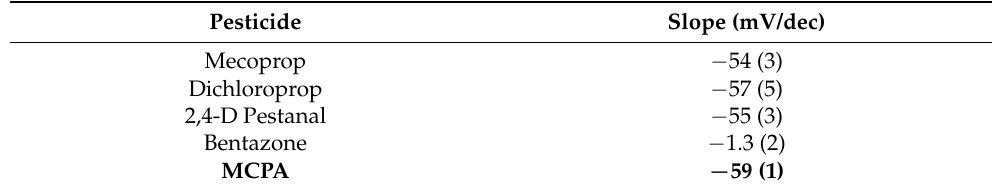
Table 2. Slopes of the calibration curves for each pesticide (average values obtained for three calibration curves for each pesticide). Numbers in parentheses are the standard deviation on the last digit.